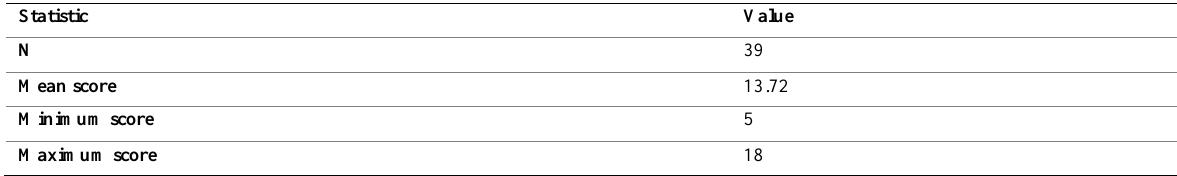
Table 3: Overall Performance of the Juvenile Justice Centre